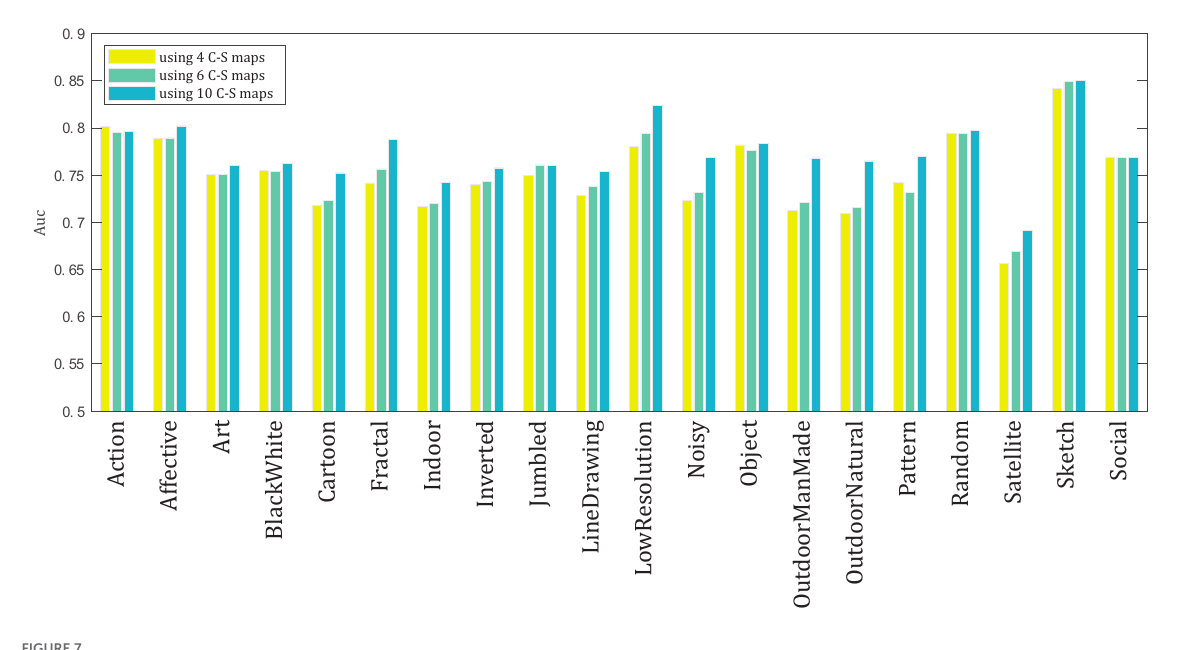
FIGURE7 The mean AUC scores of the model for the 20 categories of the CAT2000 dataset for the three cases of applying 4, 6, and 10 C–S difference maps in the